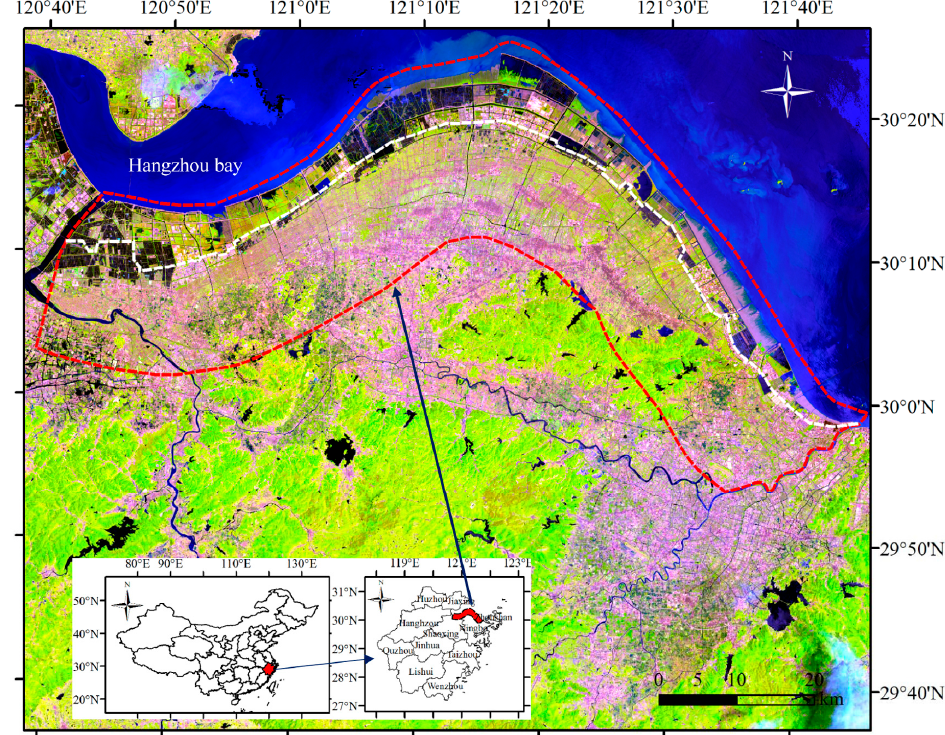
Figure 1. Location of the study area: Hangzhou Bay, Zhejiang Province, China (The red dash line is the boundary of the study area. The white dash line is the 1984 coastline defined from visual interpretation of the 1984 Landsat imagery. The regions on the land side and on the bay side of the 1984 coastline are defined as inland and reclaimed area, respectively. The color composite using the shortwave infrared, near-infrared, and red spectral bands is from a 2016 Landsat 8 Operational Land Imager image).